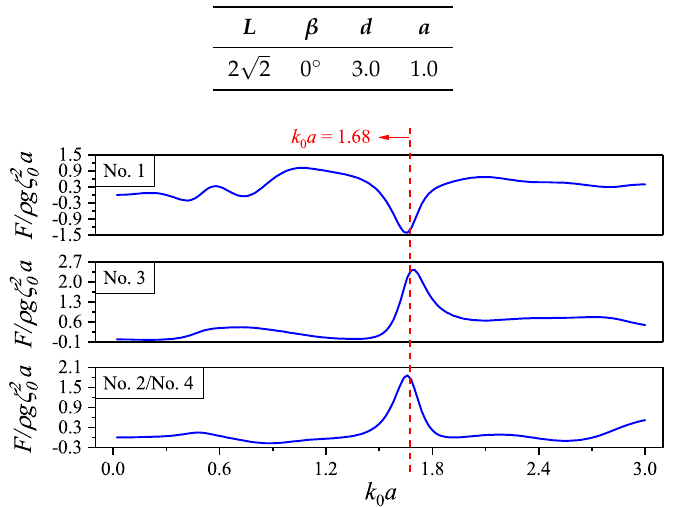
Table 1. The configuration of the four-column structure.